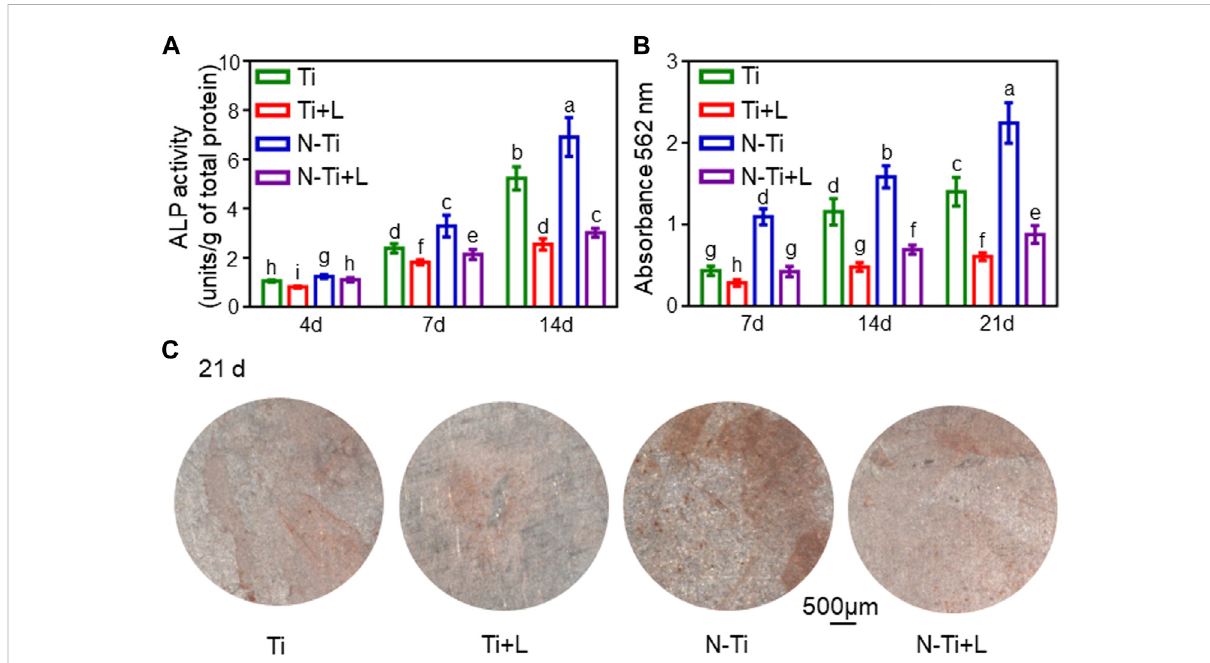
FIGURE 2 Osteogenic differentiation and mineralization of MC3T3-E1 cells on Ti, Ti+ L, N-Ti,N-Ti + Lsurfaces. (A) ALP activity of MC3T3-E1 cells seeded onTisurfacesfor4,7,and14 d. (B) Colorimetricquantitativeresultsofmineralization. (C) ARSstainingofMC3T3-E1cellsincubatedonTisurfacesfor 21 d. Results are shown as mean ± SD; n = 6/group. Values with dissimilar letters are markedly different ( p < 0.05).